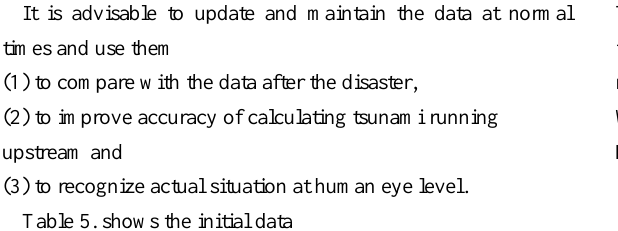
Data Topography Land point clouds Images Omnidirectional images